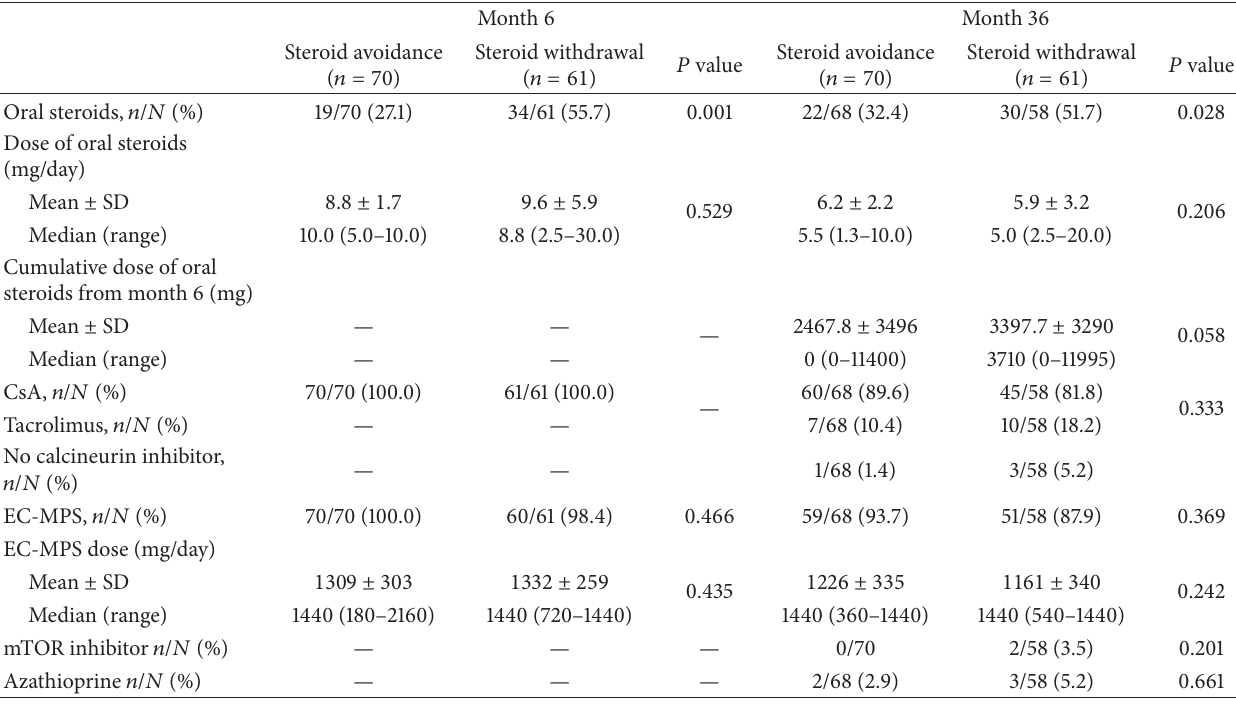
Table 2: Immunosuppression at months 6 and 36.